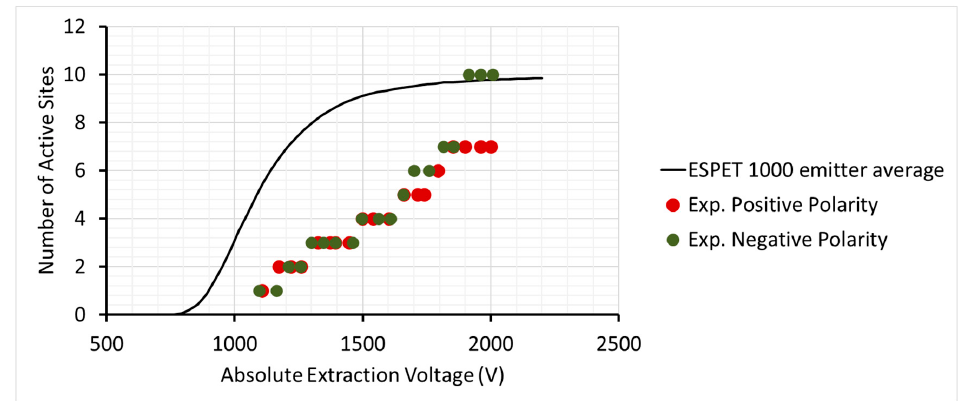
Figure 20. Number of active emission sites observed experimentally (colored dots) for both positive and negative polarities and computed with the ESPET QuickSolver for an average of 1000 emitters (positive polarity only).